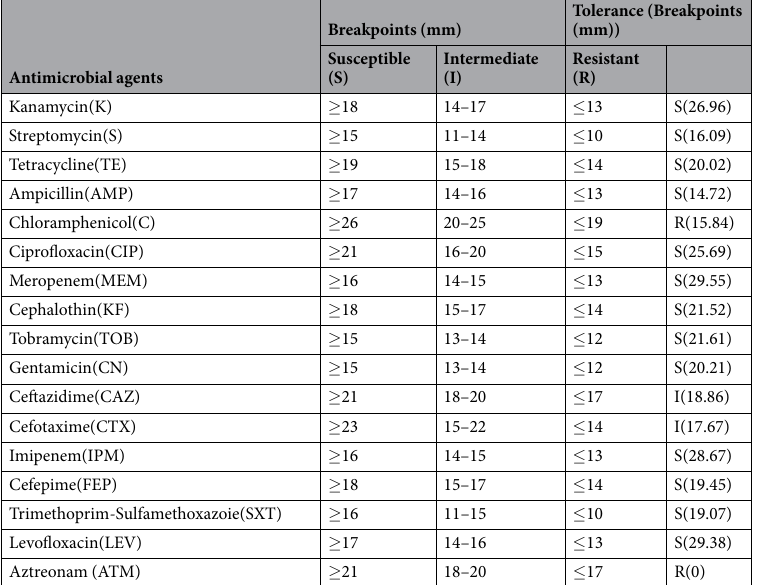
Table 2. Results of antibiotic susceptibility tests of Acinetobacter sp.